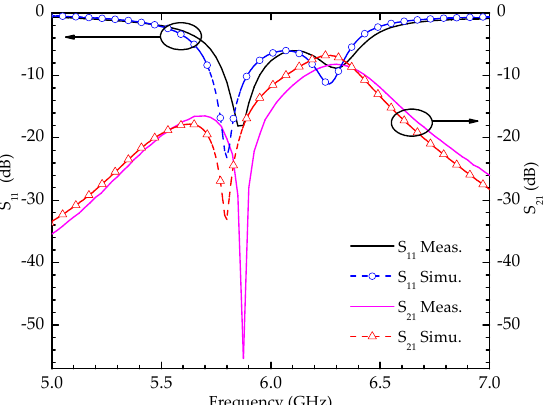
Figure 13. Measurement results compared to the simulation for the S 11 and S 21 of the designed MIMO antenna with DGS, focus on 5.8 GHz.